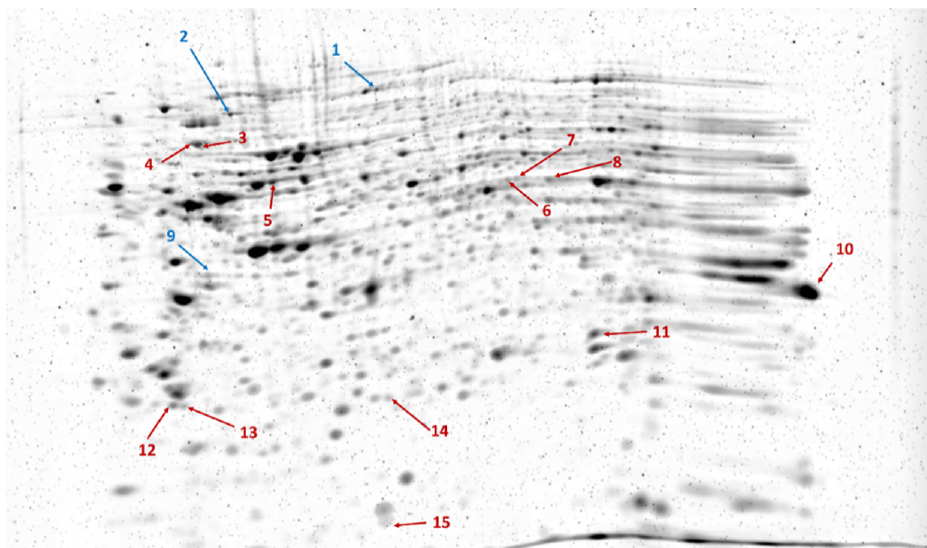
Figure 1. Expression of SARS-CoV-2 Mpro in transfected HEK293T cells. SARS-CoV-2 Mpro was detected in the lysates of transfected HEK293T cells. The recombinant protein was absent from the mock-transfected cells. Purified His 6 -SARS-CoV-2 Mpro was used as a positive control. The proteomes of the transfected cells were subjected to 2D-DIGE analysis. After separation, the gels were scanned, followed by image analysis. After warping, the fused image containing spots from all Cy-dye labeled gels was generated. In total, 339 spots were detected. Statistical analysis revealed 15 spots showing statistically significant differences between SARS-CoV-2 Mpro and mock-transfected samples. As compared to the control, only three spots showed decreased intensity (ratio: 0.49–0.87), the other spots had increased intensity (ratio: 1.43–3.96) in the SARS-CoV-2 Mpro-transfected samples (Figure 2). Proteins identified in the spots and excised from the gel are listed in Table 1.